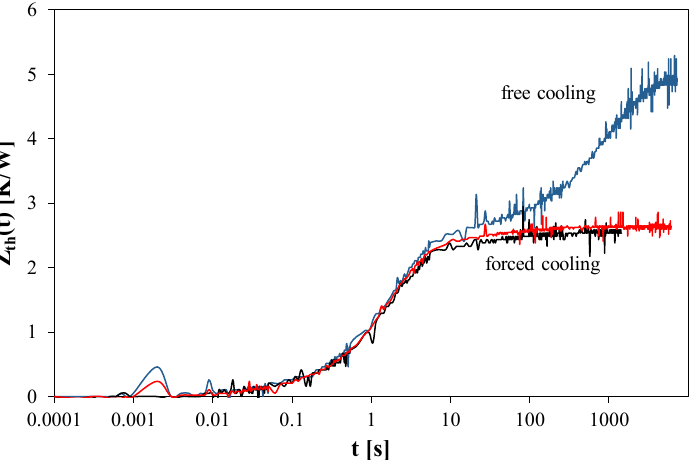
Figure 9. View of the tested transistor mounted on the heat exchanger.